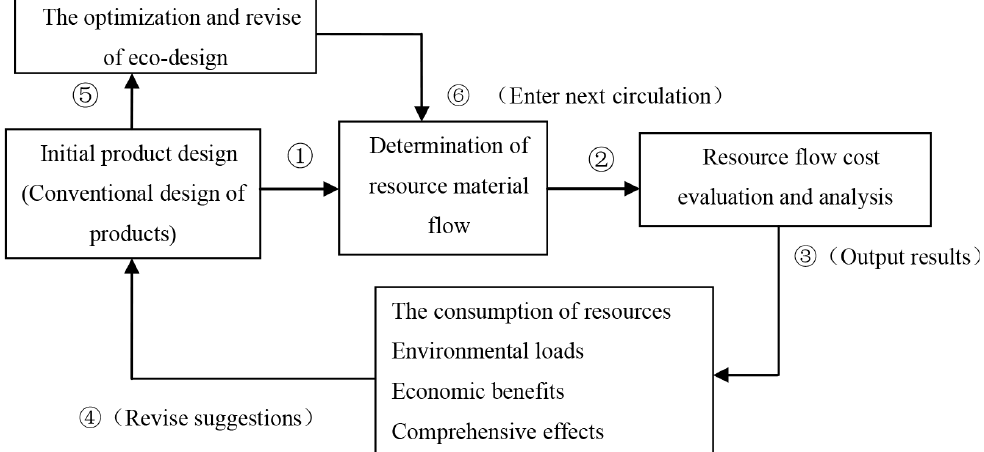
Figure 3. The logical correlation between the ecological design and resource flow